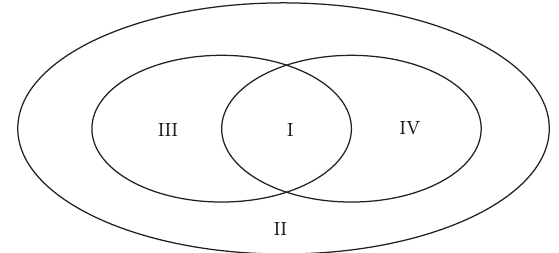
Figure 1: The implication relationships among different types of SC (I, II, III, and IV represent abbreviations of FCSC, SCSC, TCSC, and